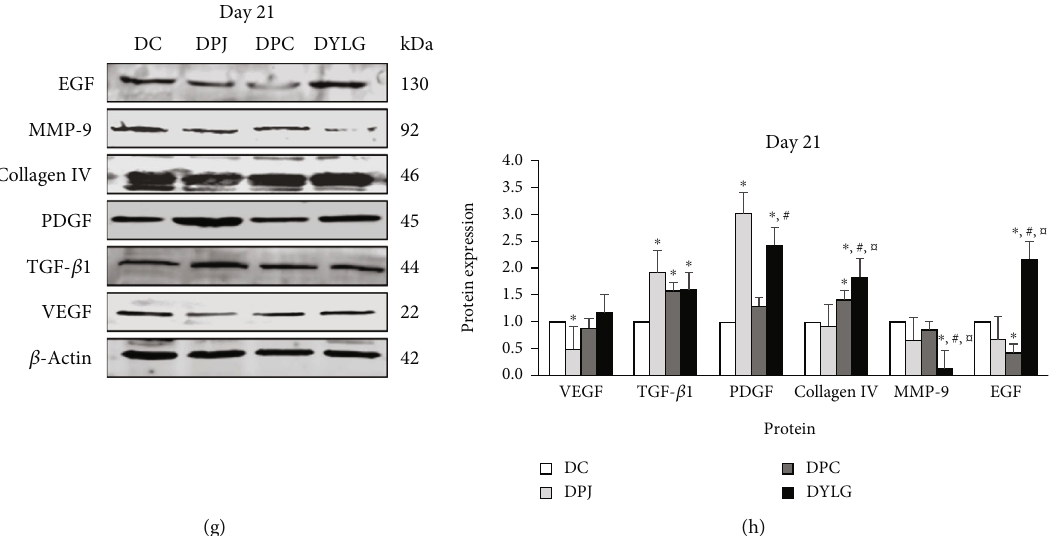
Figure 5: E ff ect of YLG on protein expressions of VEGF, TGF- β 1, PDGF, Collagen IV, MMP-9, and EGF in T2DM rats on days 3, 7, 14, and 21